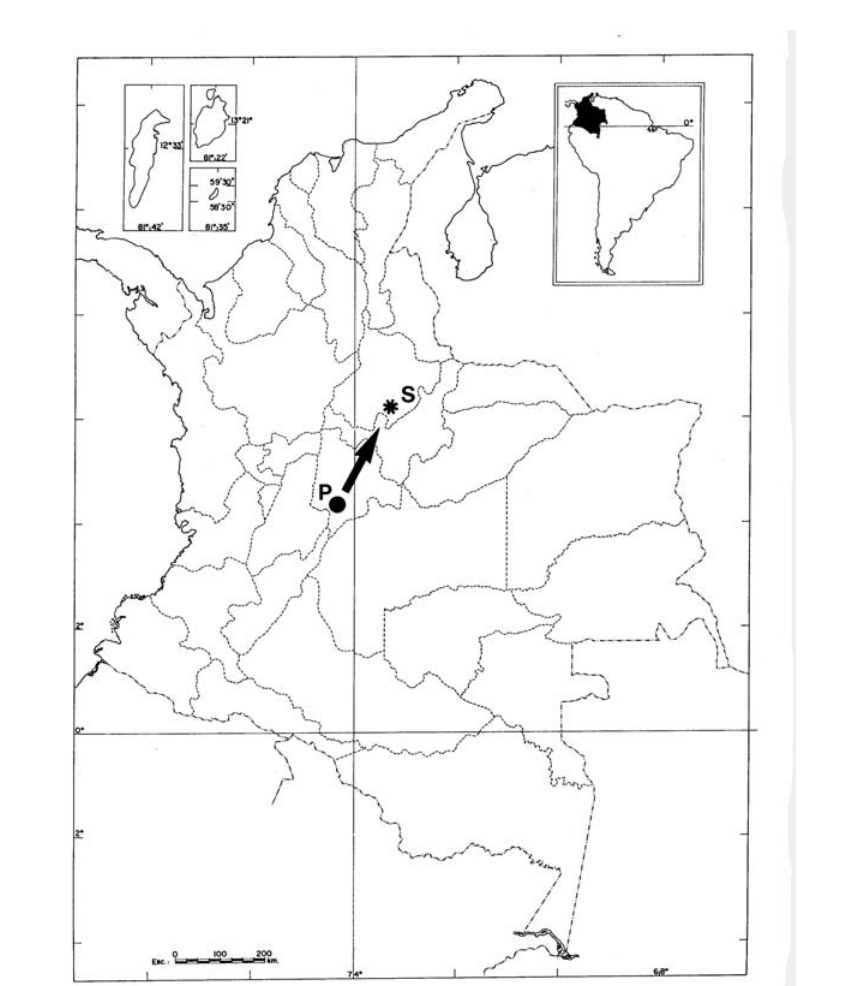
Figure 19. Location of Mosquera and Iza in Colombia where parthenogenetic (P) and sexual (S) populations of Tityus columbianus are distributed.